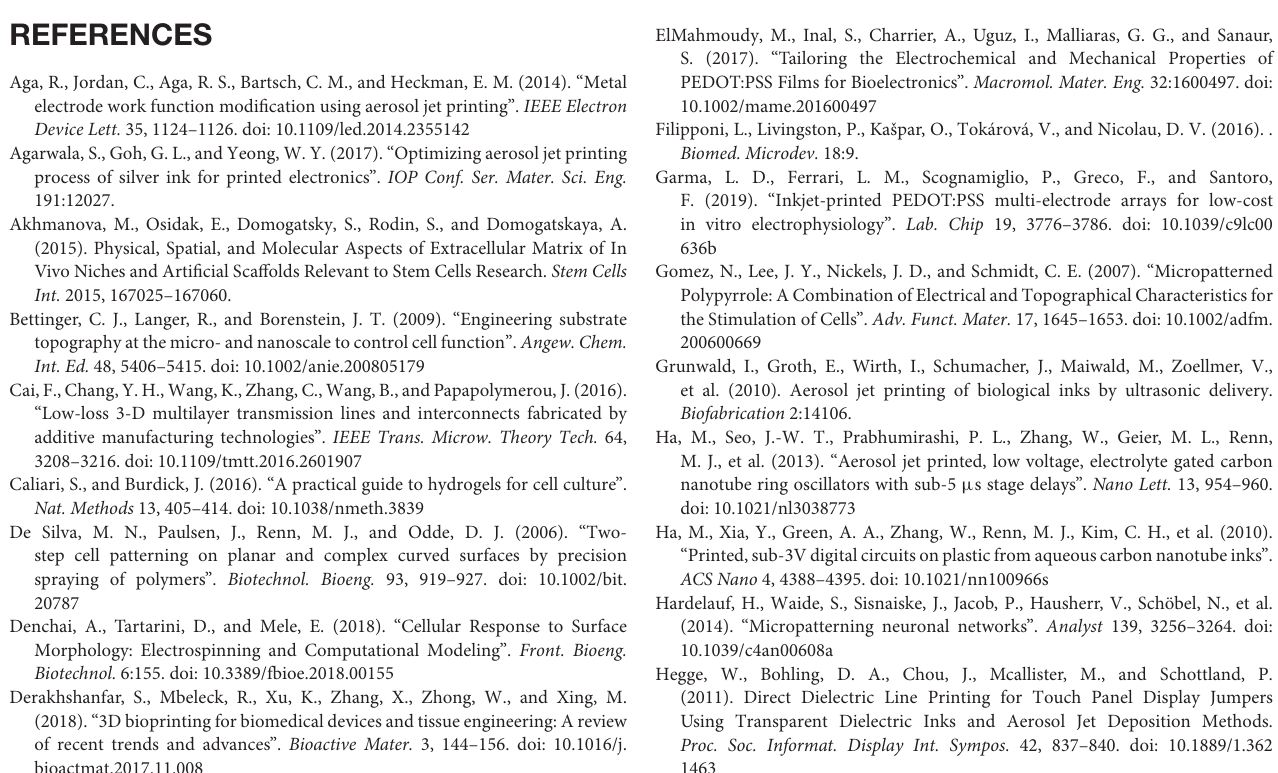
Supplementary Table 2 | Observations of print formulations P1–P9 utilized during initial material screen. Supplementary Table 3 | Full factorial design of experiment to determine optimized AJP processing parameters for the deposition of PEDOT:PSS onto a